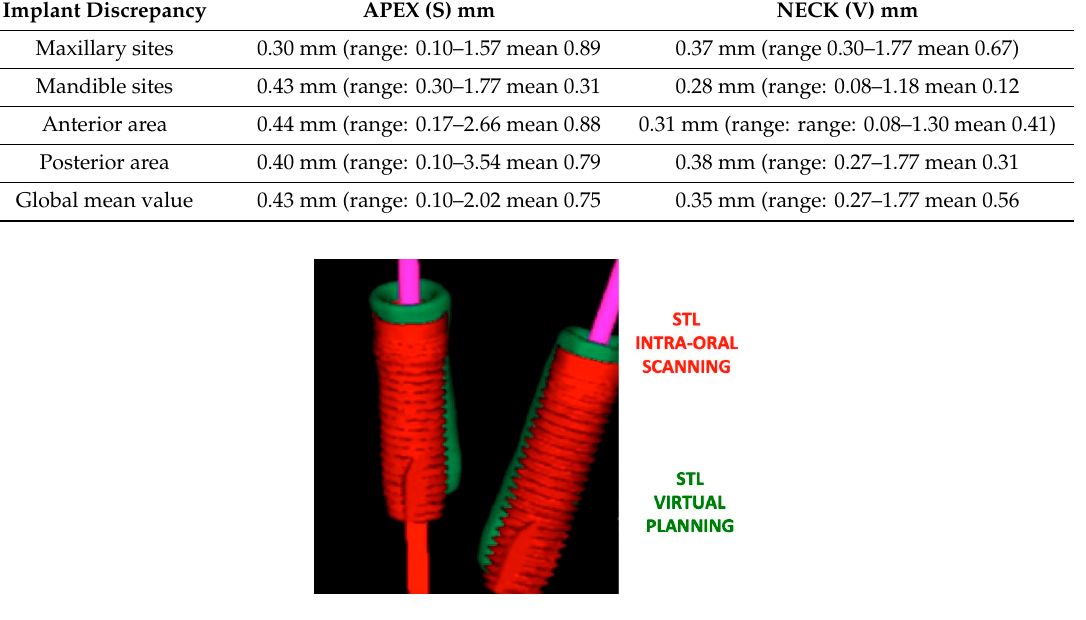
Figure 2. The 3D STL intra-oral cone-beam analysis (CBCT) scanning position data as compared to the STL virtual planning data in millimetric horizontal and spatial angle evaluation. Software reconstruction of dental implant virtual planning vs clinical position after the surgical procedure.